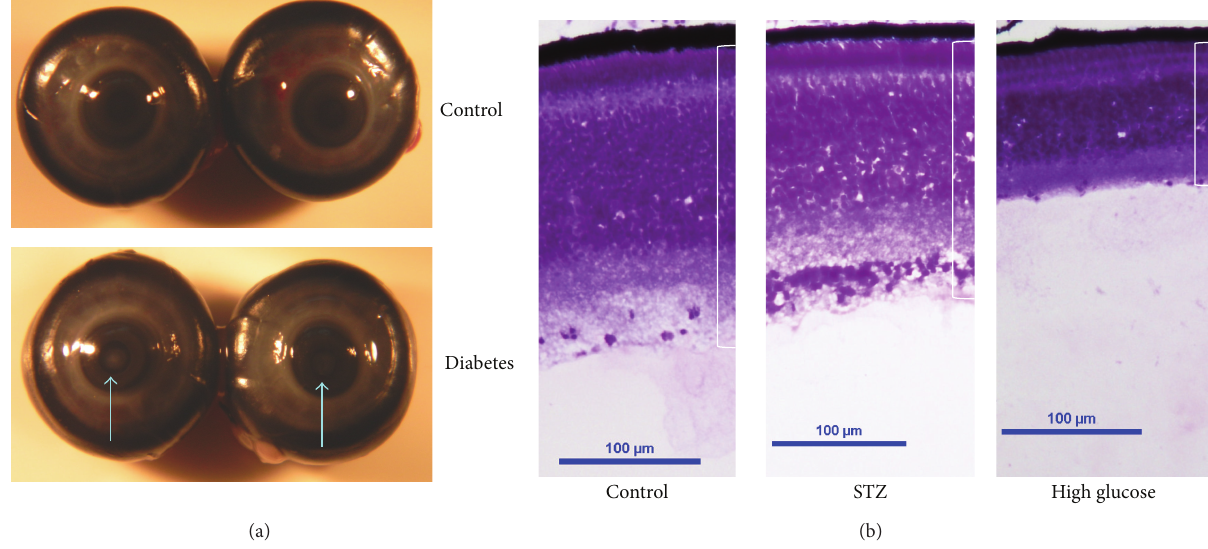
Figure 2: There are morphological changes in STZ- and high glucose-induced diabetic eyes. (a) Cataracts (arrows) occur in STZ- or high glucose-induced diabetic embryos at E18. (b) The retinas of STZ- and high glucose-induced diabetic eyes are thinner than the control eyes of the same age